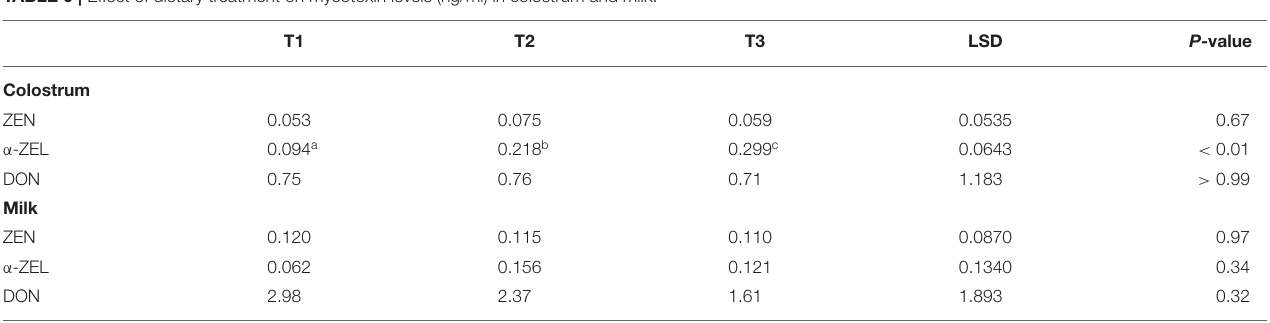
TABLE 6 | Effect of dietary treatment on mycotoxin levels (ng/ml) in colostrum and milk. T1 T2